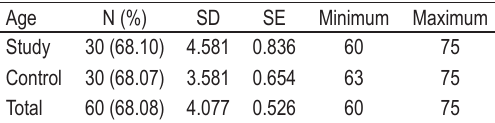
TABLE 1. Comparison of average age by groups